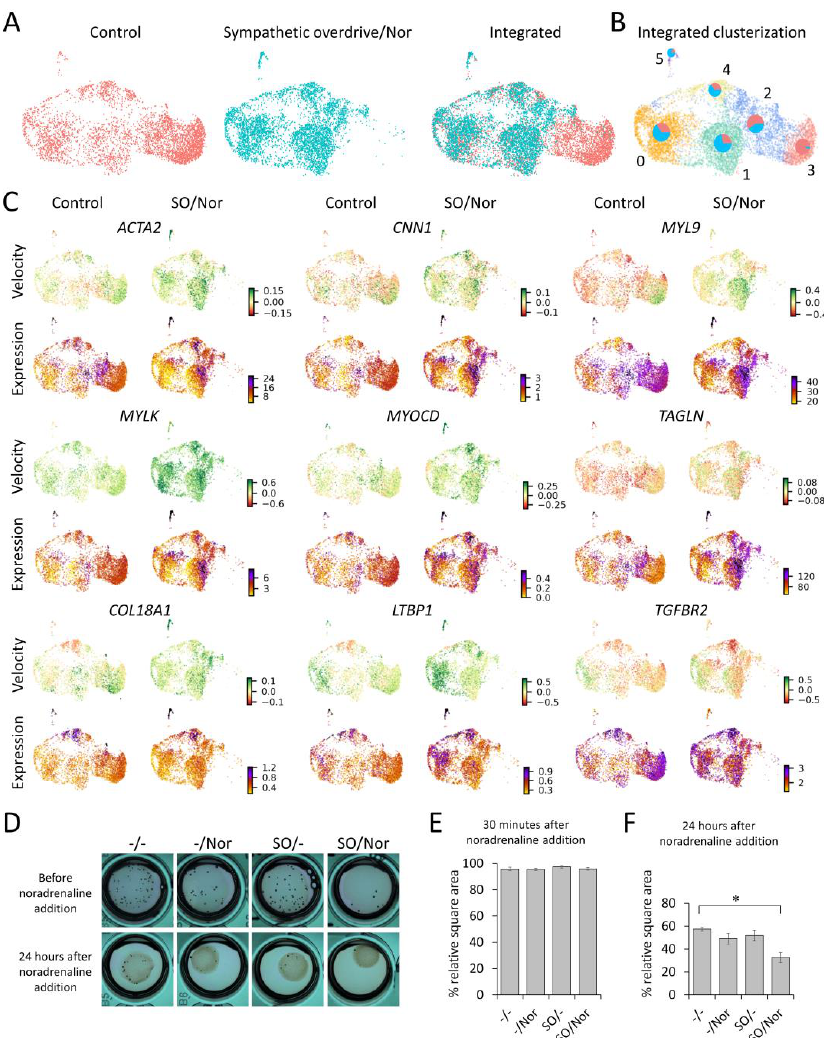
Figure 3. Evaluation and functional analysis of MSCs’ contractile properties after sympathetic overdrive followed by noradrenaline. ( A – C ) scRNAseq analysis of MSCs after sympathetic overdrive followed by noradrenaline addition. ( A ) Uniform manifold approximation and projection (UMAP) representation of MSCs from the control and experimental sample. Samples are positioned in the same coordinates by their transcriptomic similarity separately and after integration. Cells were integrated and visualized by Seurat. ( B ) Clustering of integrated samples with a visualized proportion of cells in each cluster. Red sectors of circles correspond to the portion of control cells in a particular cluster, blue sectors correspond to the cells after sympathetic overdrive followed by noradrenaline addition. ( C ) mRNA velocities (velocity) and expression (expression) of some particular genes projected onto UMAP plots of control and experimental samples. ( D ) Collagen disks with MSCs ’ contraction just before noradrenaline addition and 24 h after noradrenaline addition. Vehicle-treated MSCs (-/-), MSCs treated with noradrenaline alone (-/Nor); MSCs after sympathetic overdrive with- out followed noradrenaline treatment (SO/-); MSCs treated by noradrenaline after sympathetic overdrive (SO/Nor) ( n = 3 – 6). ( E , F ) Relative square area of collagen disks containing MSCs 30 min ( E ) and 24 h ( F ) after noradrenaline treatment. * p < 0.05 calculated with Kruskal – Wallis One Way ANOVA on Ranks.